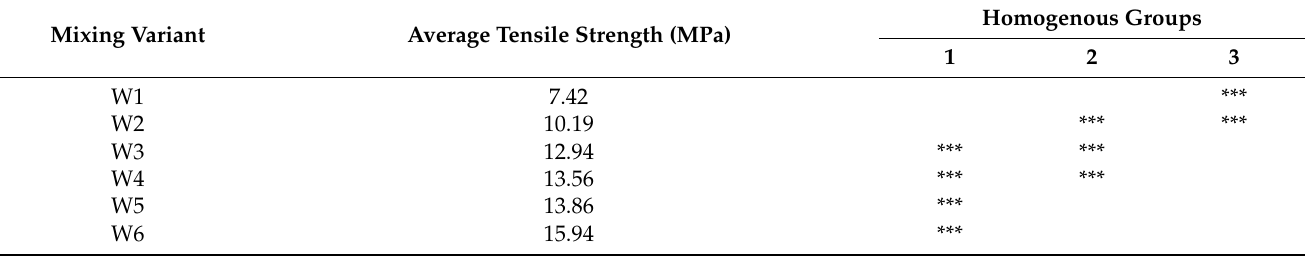
Table A6. Results of Tukey’s post hoc (HSD) tensile strength test for E57/Z-1/CWZ-22/100:10:20 composition. Mixing